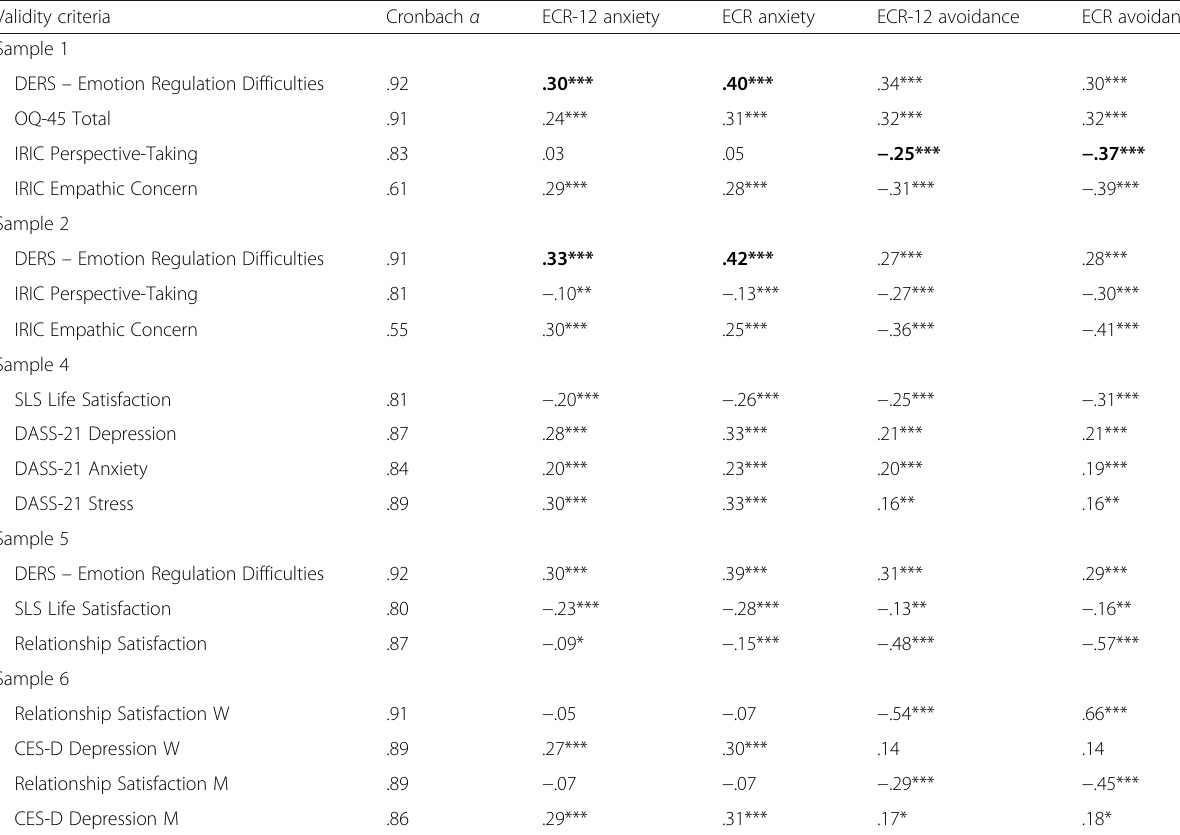
Table 2 Cronbach ’ s alpha for the validity criteria and standardized regression coefficients from analyses in which ECR subscales predicted these criteria across